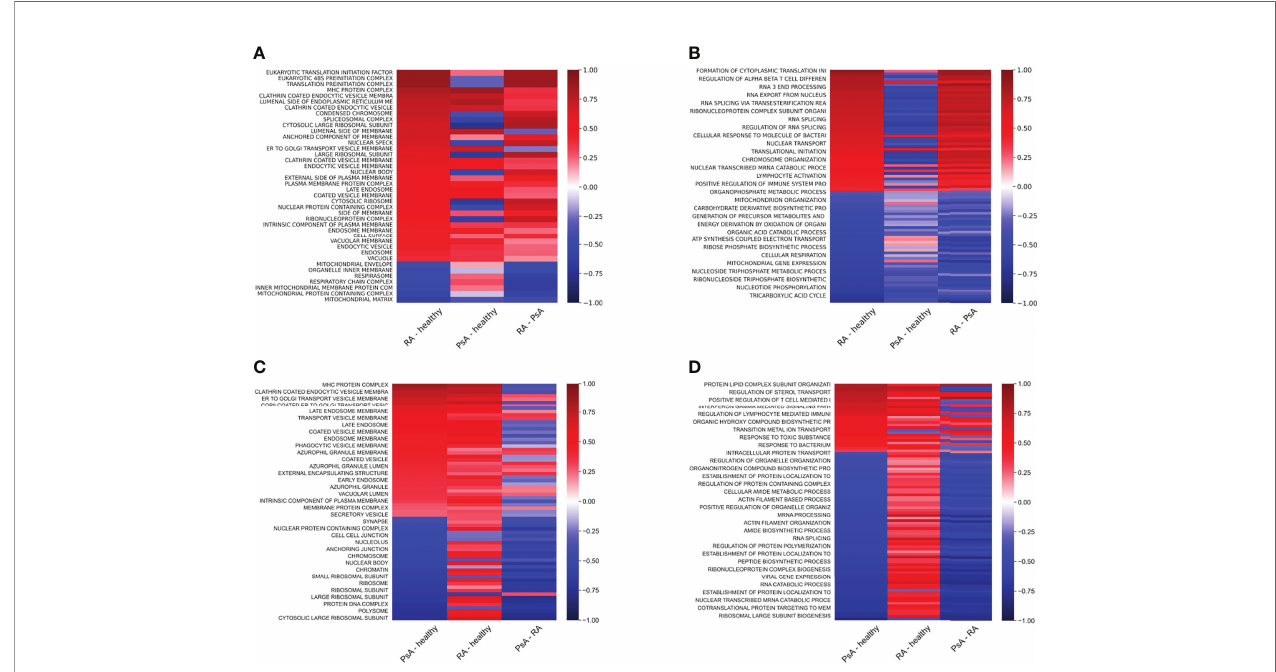
FIGURE 7 | Protein expression differences of RA and PsA samples compared to healthy samples. Heat maps representing the sample protein localizations (A, C) , or functions (B, D) analyzed with protein GSE using GO: Cellular Compartments (A, C) and Biological Process terms (B ,D) for RA versus healthy (A, B) , or PsA versus healthy (C, D) samples. Terms with the smallest adjusted p-values are shown on the heat-map. Not all terms are indicated on the y-axis, the full table with p values are provided in Supplementary Table 6 .